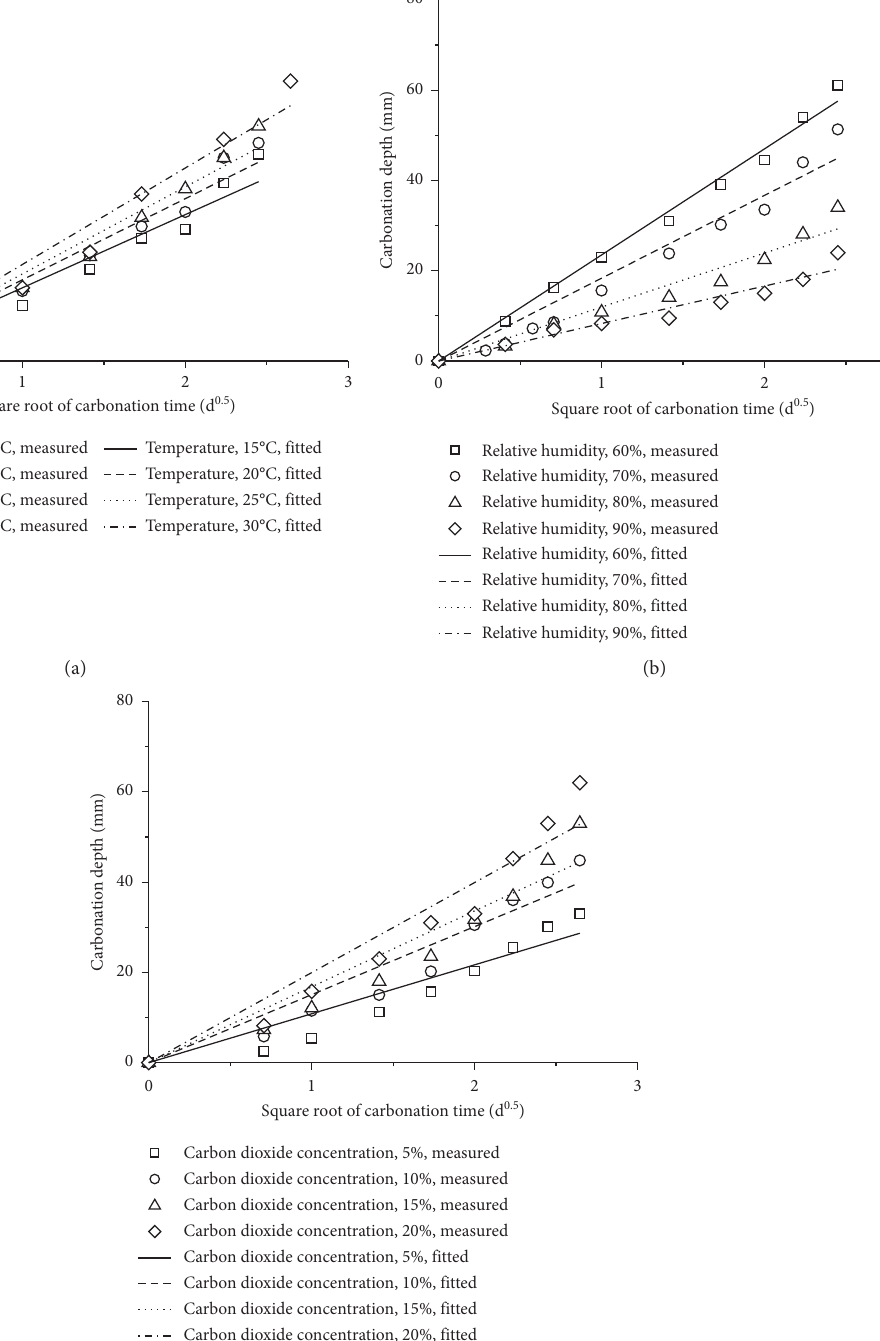
Figure 7: Relationships between carbonation depth and square root of carbonation time, effect of (a) temperature, (b) relative humidity, and (c) carbon dioxide